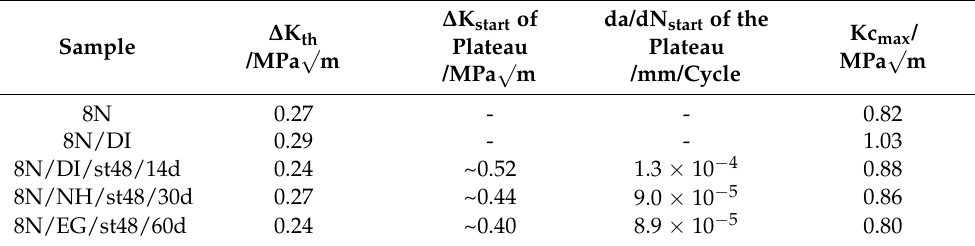
Table 3. Determined values ( ∆ K Threshold and Kc max ) from the dynamic fatigue measurements under ESC for DI via the two wetting procedures and the neat PMMA